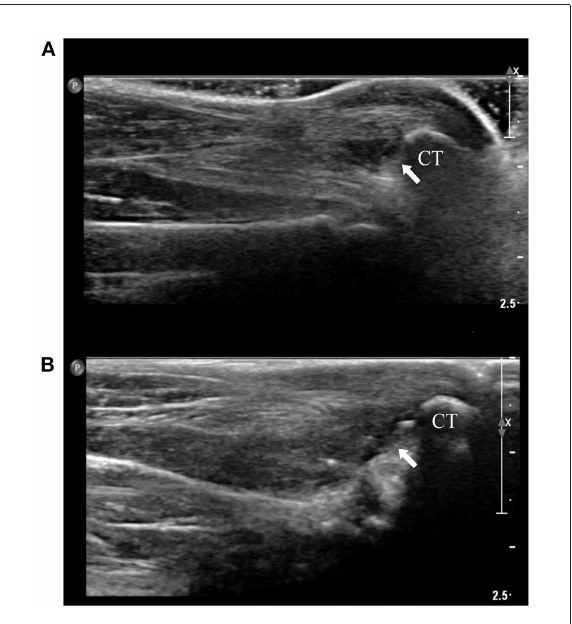
FIGURE2 Ultrasonography. (A) Longitudinal view of left calcaneal tendon and calcaneus at the initial evaluation. There is a heterogeneous hypoechoic lesion (arrow), indicating moderate fluid accumulation and/or inflammation within the bursa. (B) Longitudinal view of left calcaneal tendon and calcaneus at 4 weeks postoperatively. Absence of the lesion can be confirmed (arrow). Calcaneus tuberosity was indicated as CT on the